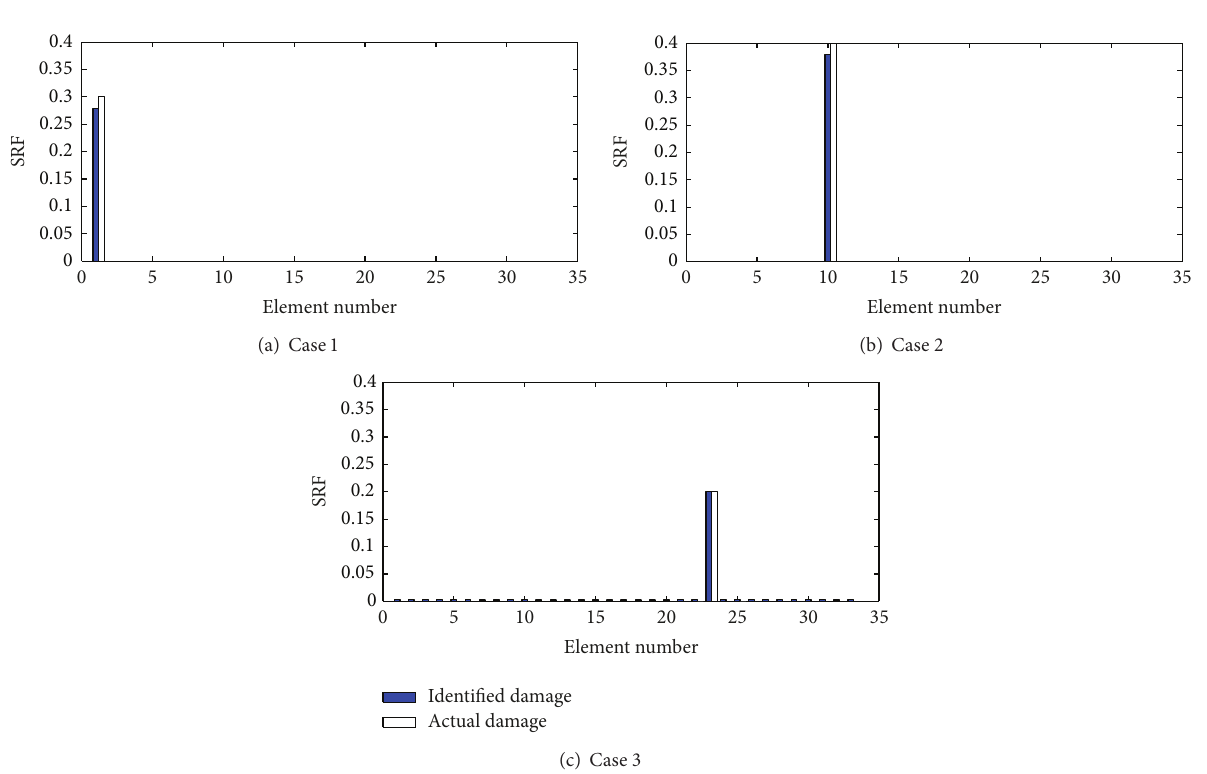
Figure 4: Damage detection results using free-interface modal synthesis based substructure sensitivity method.